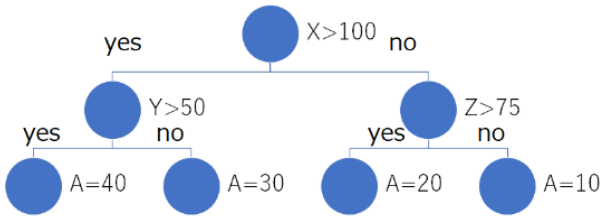
Figure 3. Example of decision-tree-based discrimination.